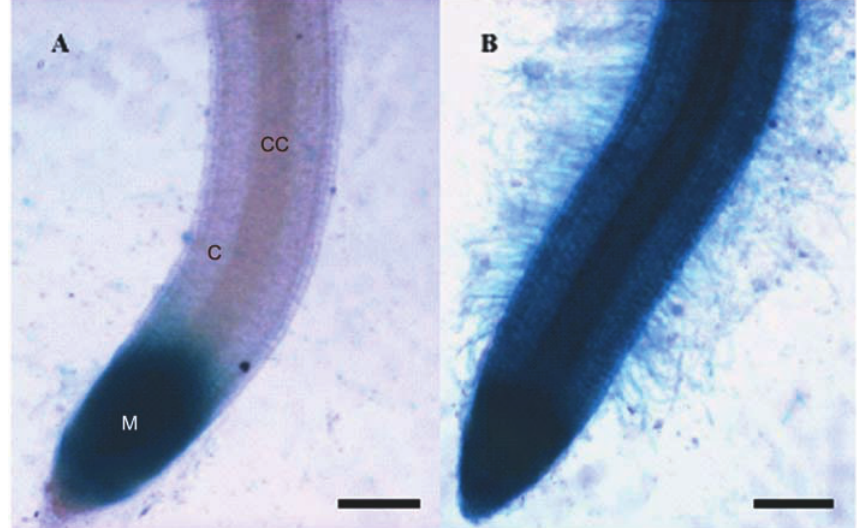
Fig. 5 – Bright field microscopy of the GUS expression pattern in the root of transgenic seven-day- old rice plantlets. ( A ) DR5-GUS activity in control plantlets was detected only in the meristematic tissue, M . ( B ) Root system showing extensive blue stained due the DR5-GUS activity in response to B. kururiensis . Radicular cortex, C ; Central cylinder, CC ; Bar = 100 μ